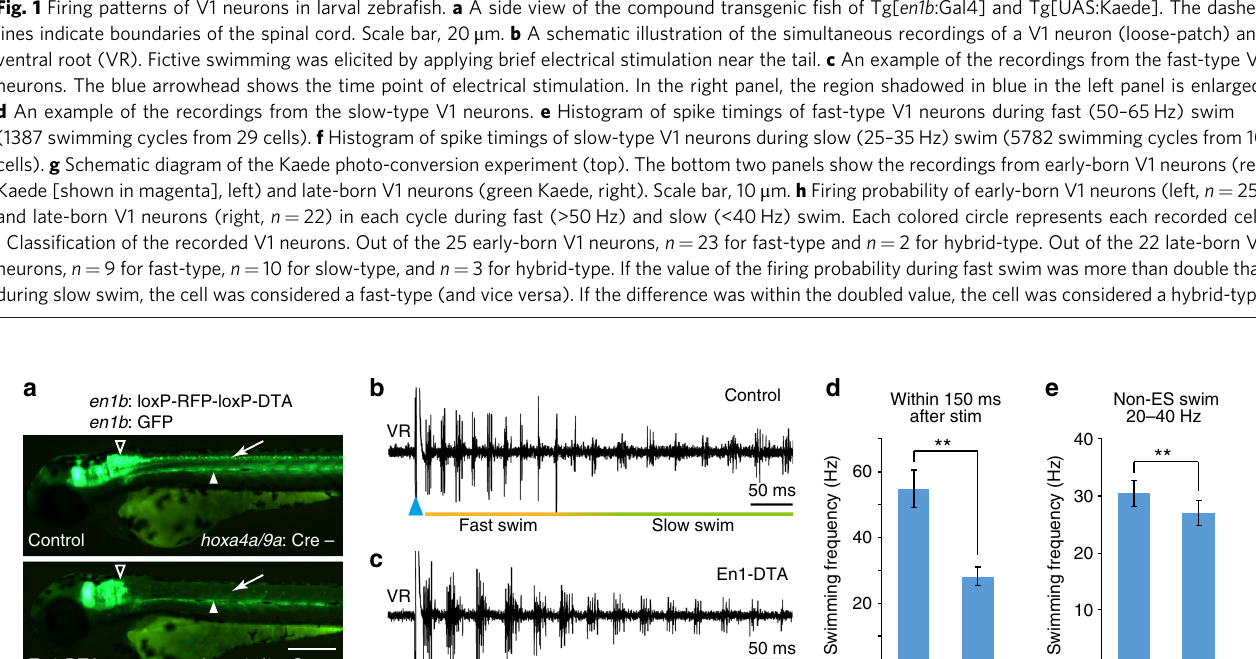
Fig. 2 V1 ablation reduced cycle frequency in swimming. a Fluorescent images (green channel) of Tg[ en1b :GFP] and Tg[ en1b :loxP-RFP-loxP-DTA] fi sh with (bottom panel) or without (top panel) Tg[ hoxa4a/9a :Cre]. Green fl uorescent protein (GFP) expression in the spinal V1 neurons (arrow) is absent in the presence of Cre (En1-DTA), with GFP expression in the brain (triangle) and slow muscle cells in the middle region of the body (arrowhead) being intact. Scale bar, 250 μ m. b , c Ventral root recordings of fi ctive swimming elicited by electrical stimulations (ESs) in a control ( b ) and an En1-DTA fi sh ( c ). d Swimming frequency of control and En1-DTA fi sh during the initial phase of ES swim (swimming elicited by electrical stimulation). Control: 54.8 ± 5.7 Hz, number of fi sh = 73. En1-DTA: 28.0 ± 2.9 Hz, n = 57. ** P < 0.01 (two-tailed t test, P = 6.4 × 10 − 62 ). e Swimming frequency of control and En1-DTA fi sh during Non-ES swim. Swim cycles with frequencies within 20 – 40 Hz were picked up and averaged. Control: 30.5 ± 2.3 Hz, n = 73. En1-DTA: 27.1 ± 2.2 Hz, n = 57. ** P < 0.01 (two-tailed t test, P = 2.6 × 10 − 14 ). Data are mean ±